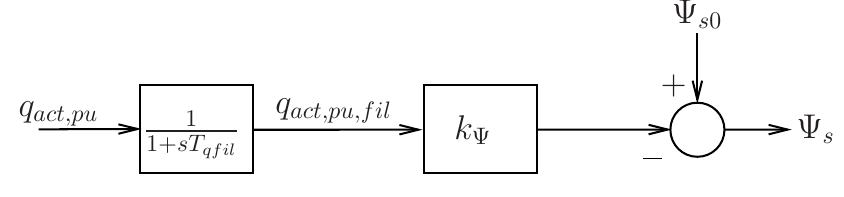
Figure 7. Adjustment of stator flux